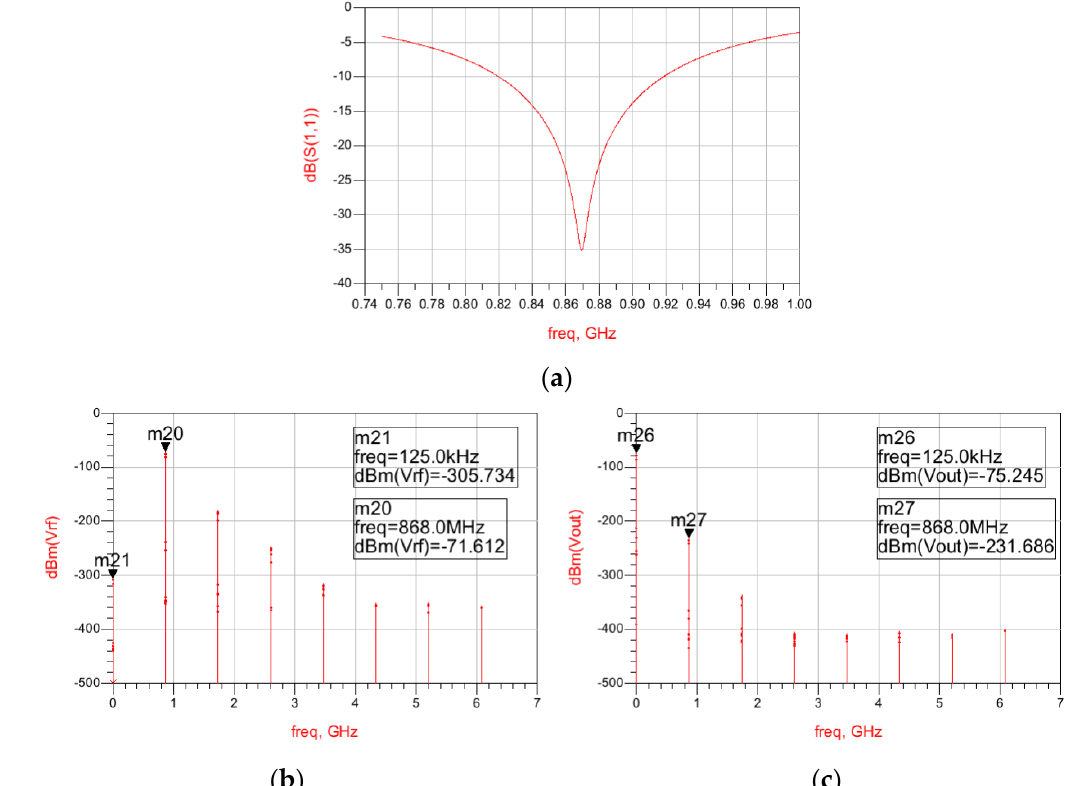
Figure 6. Input Return Loss simulation results of the feedback WuR with amplification and low-pass filtering stages ( a ) and harmonic balance simulation results of the WuR for the RF input signal ( b ) and the WuR’s output ( c ).